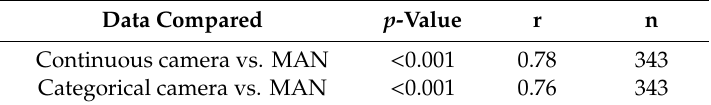
Table 1. Pearson correlation for cattle body condition scores (scale 1 to 5, low to high, n = 343) for continuous and categorical automated camera scoring versus manual scoring averages (MAN).